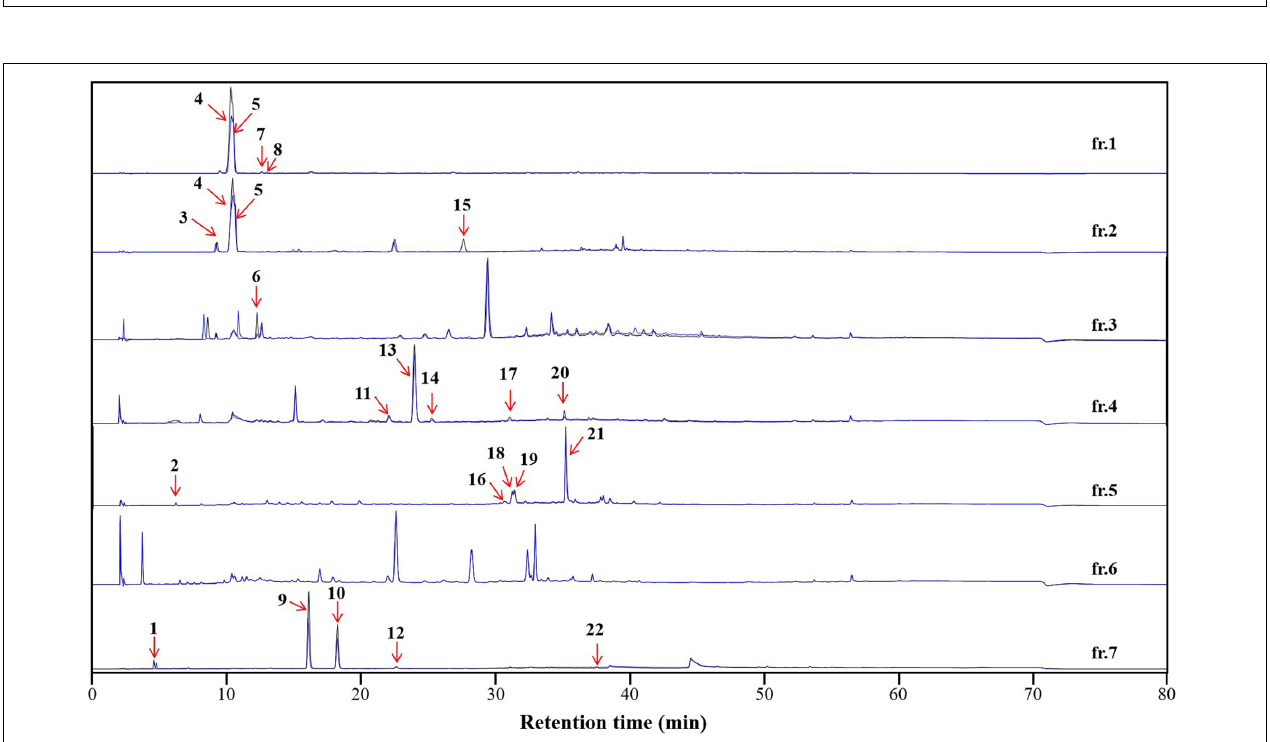
FIGURE 6 | Stepwise high-speed counter-current chromatography (HSCCC) for the enrichment of the minor components in the Dryopteris crassirhizoma rhizome (DCR) extract. (A) HSCCC elution and washing steps. (B) Mobile phases of the solvent system. (C) HSCCC profile. Stationary phase: water– n- butanol [1:10 (v/v)], flow rate: 4 ml/min, rotation speed: 400 rpm, mode: tail-to-head.